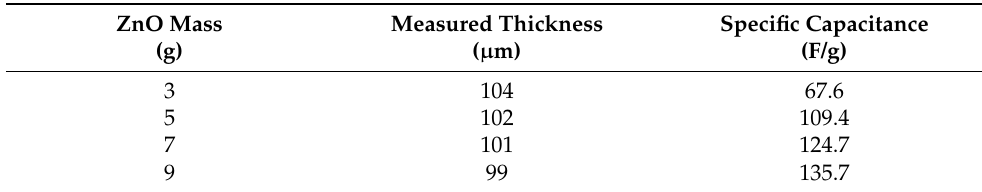
Figure 2. XRD patterns of ZnO nanostructures, AC, and AC/ZnO composite. Table 1. Measured thickness and specific capacitance for various electrodes fabricated with different amounts of